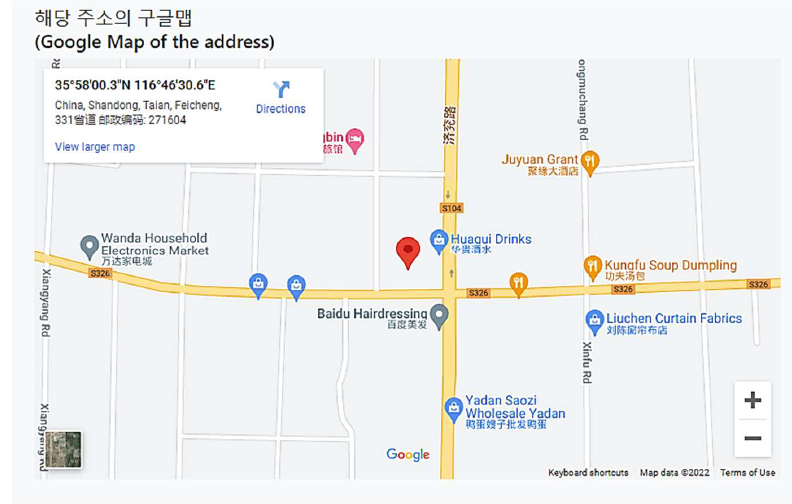
Figure 9. Location for the manufacturer address provided by Google Map